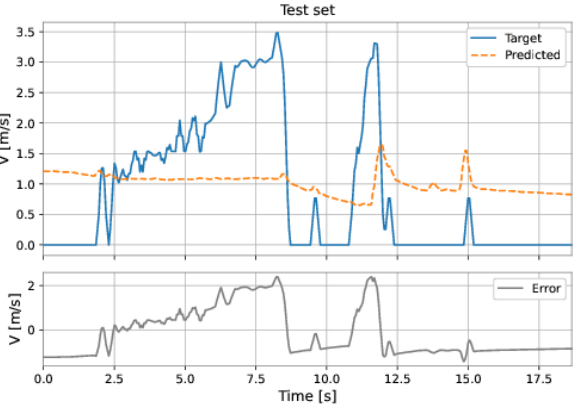
Figure 45. Linear regression predictions on the training. The orange dashed line is the velocity predicted by the model, the blue solid line is the target velocity, and the gray line is the absolute error, defined as the target velocity minus the predicted v.